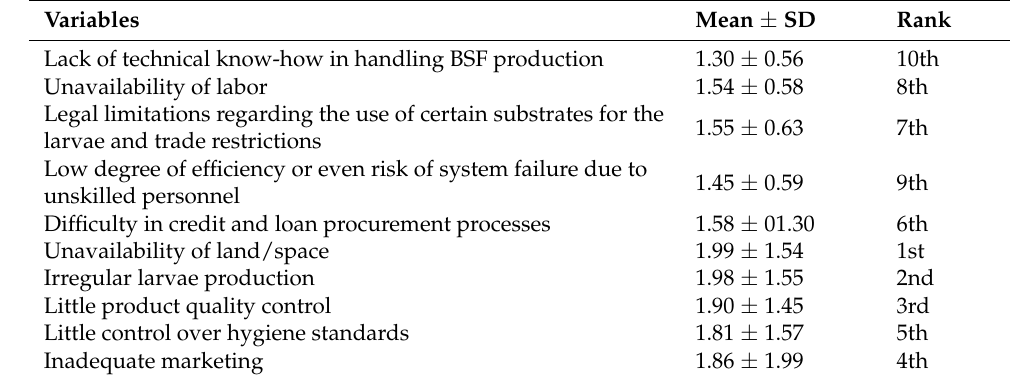
Table 3. Distribution of respondents on the perceived constraints of BSF as a protein source for poultry feed among farmers in Oyo State.